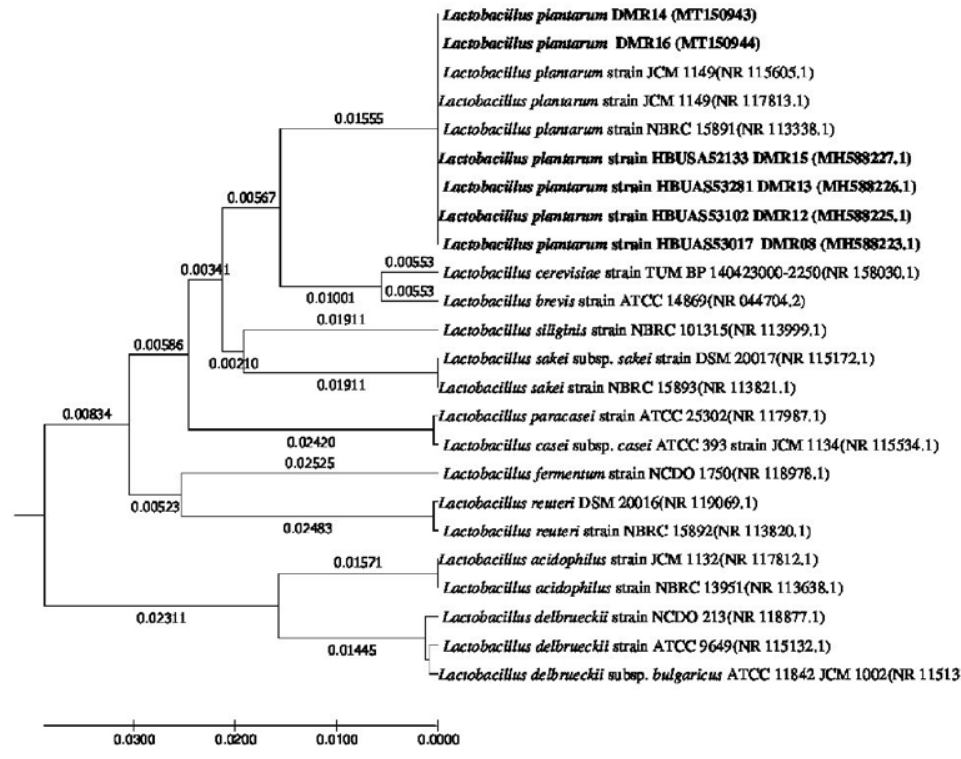
Fig. 8. Evolutionary relationship of taxa. The evolutionary history was inferred using the UPGMA method 1 . The optimal tree with the sum of branch length = 0.25083902 is shown. The tree is drawn to scale, with branch lengths (next to the branches) in the same units as those of the evolutionary distances used to infer the phylogenetic tree. The evolutionary distances were computed using the Maximum Composite Likelihood method 2 and are in the units of the number of base substitutions per site. The analysis involved 25 nucleotide sequences. Codon positions included were 1st+2nd+3rd+Noncoding. All positions containing gaps and missing data were eliminated. There were a total of 658 positions in the final dataset. Evolutionary analyses were conducted in MEGA7 3